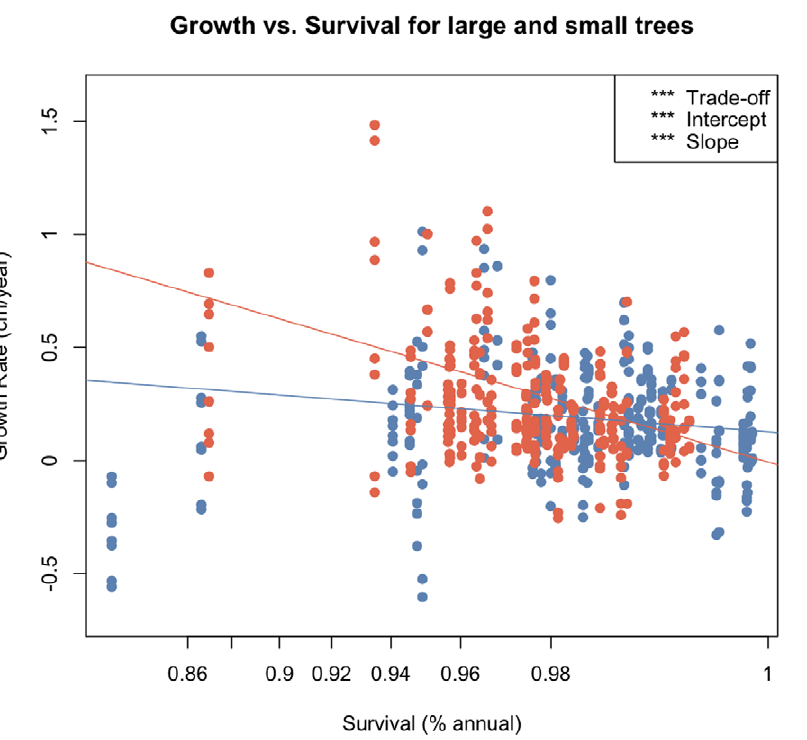
Figure 1. Growth versus survival for large trees (blue) and small trees (red). ‘‘Trade-off’’ shows an overall significant negative relationship between growth and survival. The ‘intercept’ term refers to a difference in intercepts between small and large trees, and a ‘slope’ difference refers to the different slope between large and small trees. These differences indicate that the growth survival trade-off is more pronounced for smaller trees (red line). ANOVA table details in Table 1. Significance codes for all figures: 0 ‘***’ 0.001 ‘**’ 0.01 ‘*’ 0.05 ‘.’ 0.1 ‘ ’ 1.